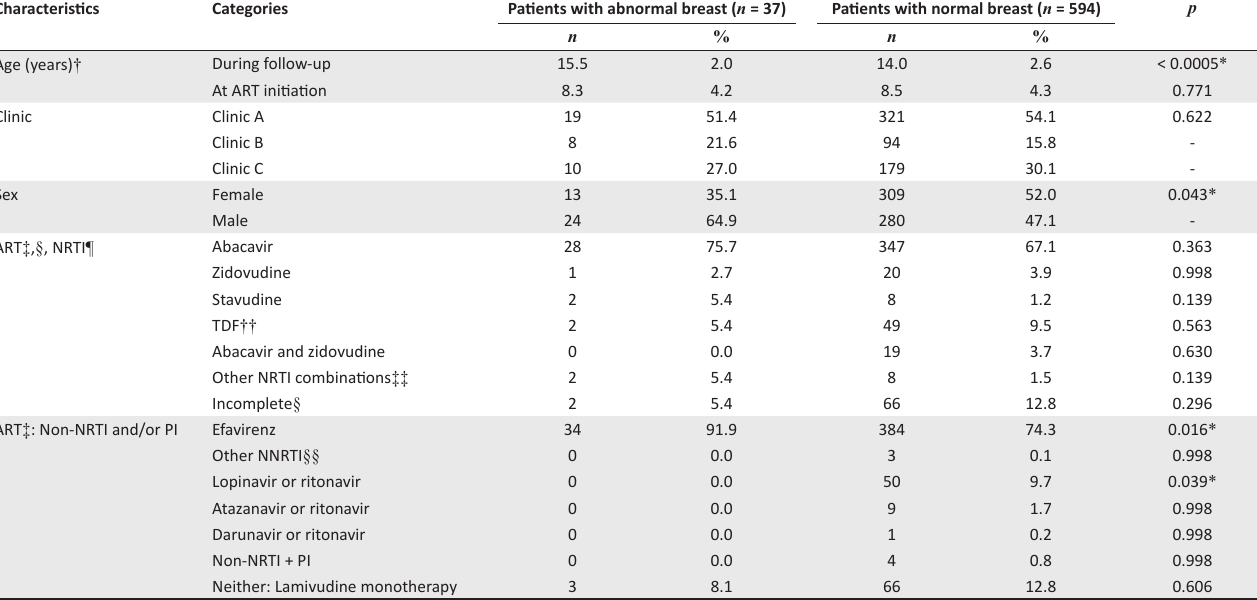
FIGURE 1: Age-related body mass index (kg/m 2 ) scatter plot for breast events reported in male and female adolescents on antiretroviral therapy (male: n = 27; female: n = 14). TABLE 3: Association of breast abnormalities to patient characteristics and prescribed antiretroviral therapy ( n = 631).